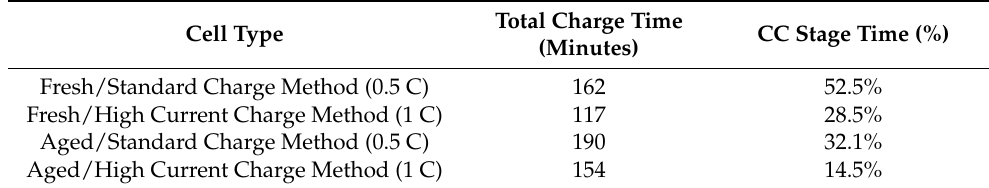
Table 3. Comparison between the charging behavior of a fresh cell and a high current charge aged cell, when both cells are charged under standard (0.5 C) and high current